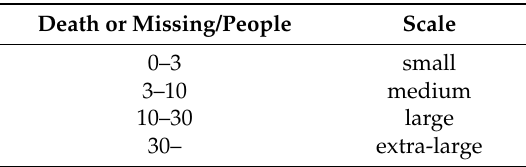
Table 1. Divisional criteria of flash floods.